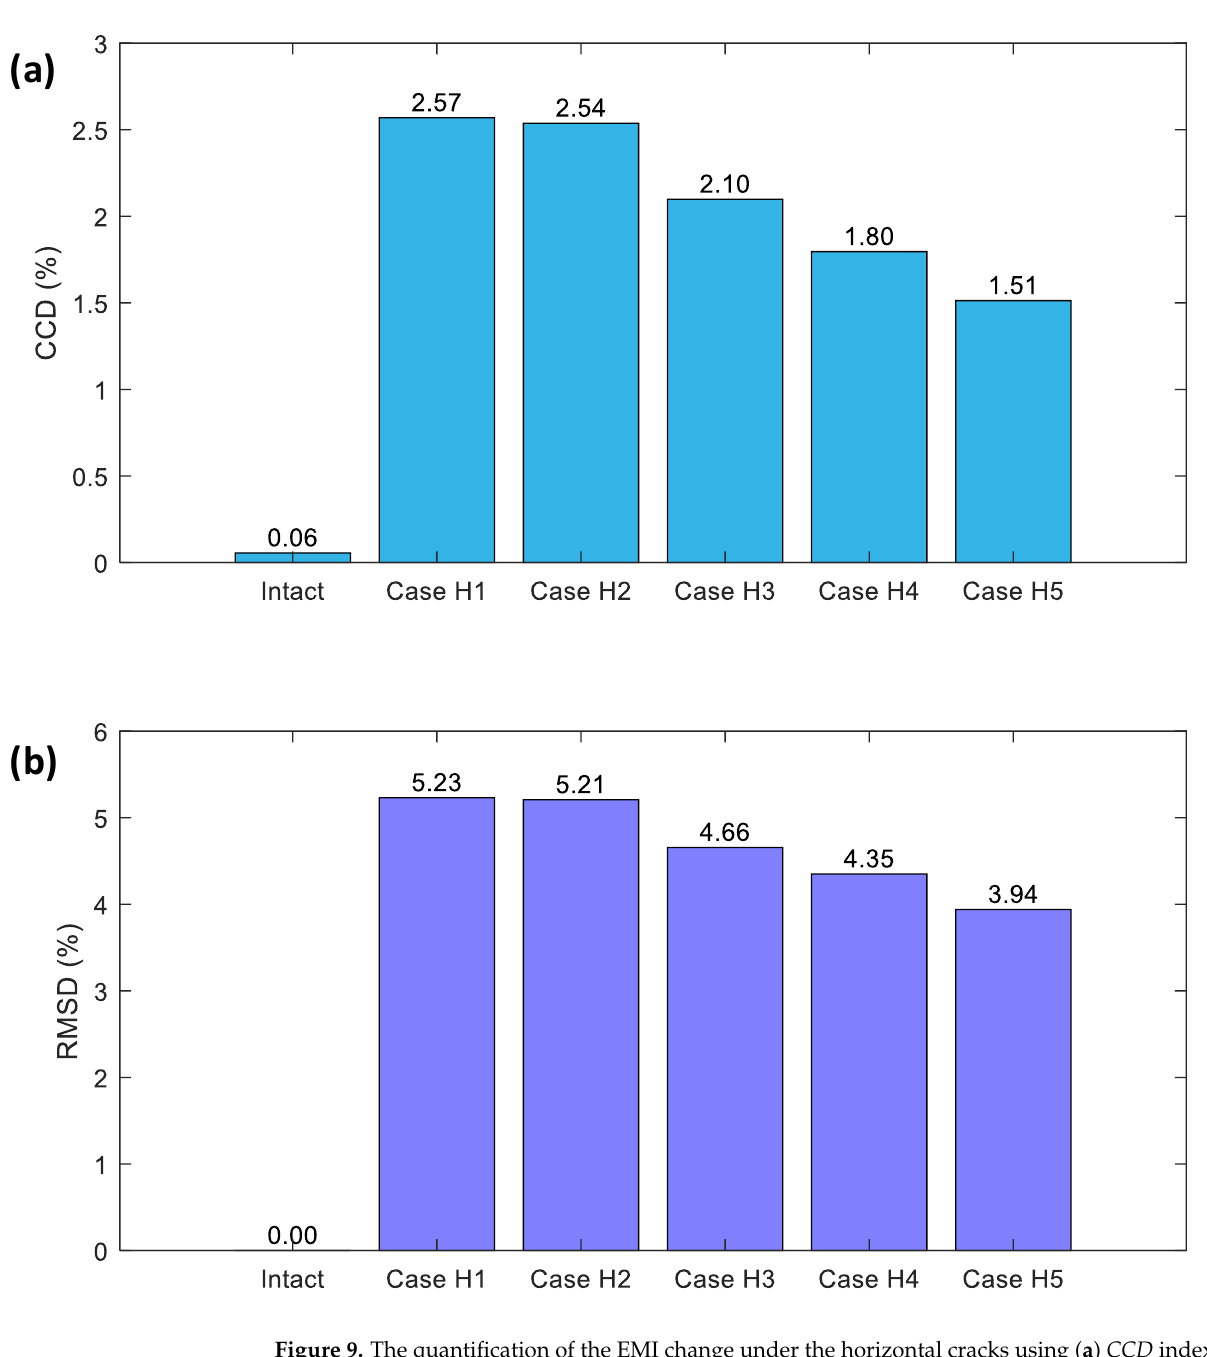
Figure 9. The quantification of the EMI change under the horizontal cracks using ( a ) CCD index and ( b ) RMSD index.